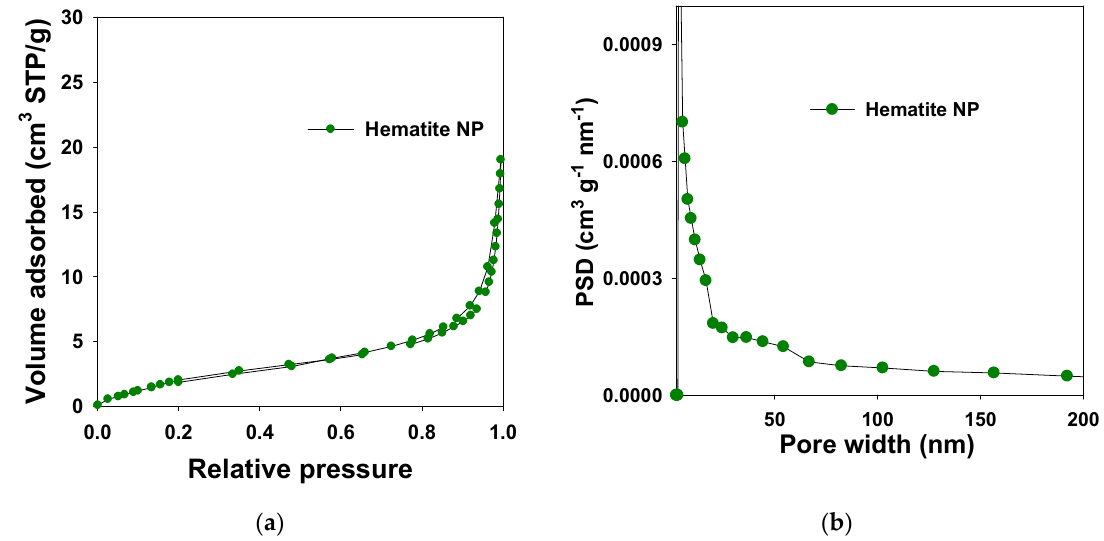
Figure 4. N 2 adsorption isotherms ( a ) and their corresponding PSD curve ( b ) for hematite nanoparticle studied.